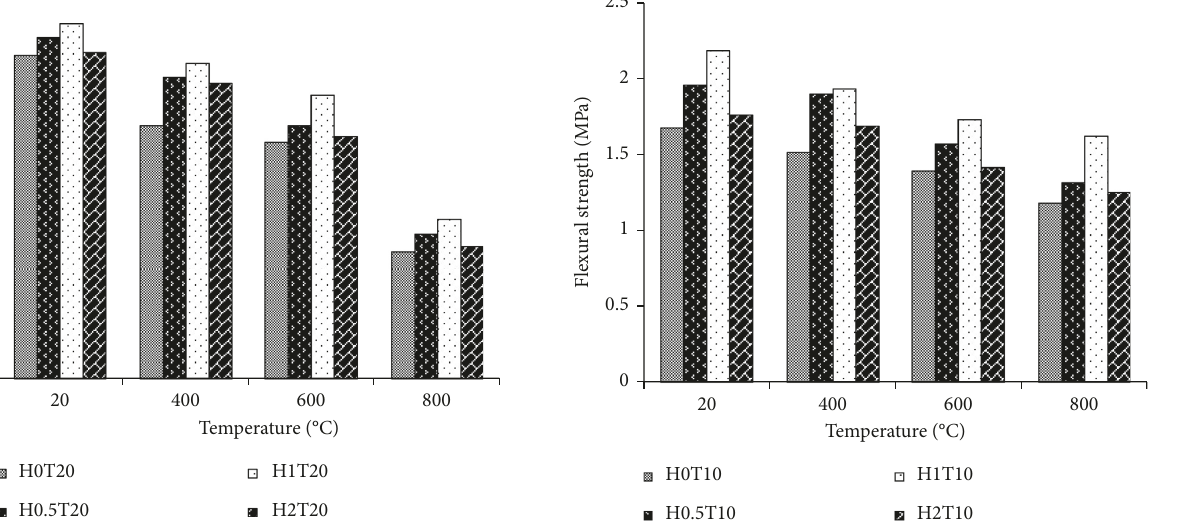
Figure 5: Flexural strength results for carbon fiber-reinforced lightweight concrete containing 10% silica fume.